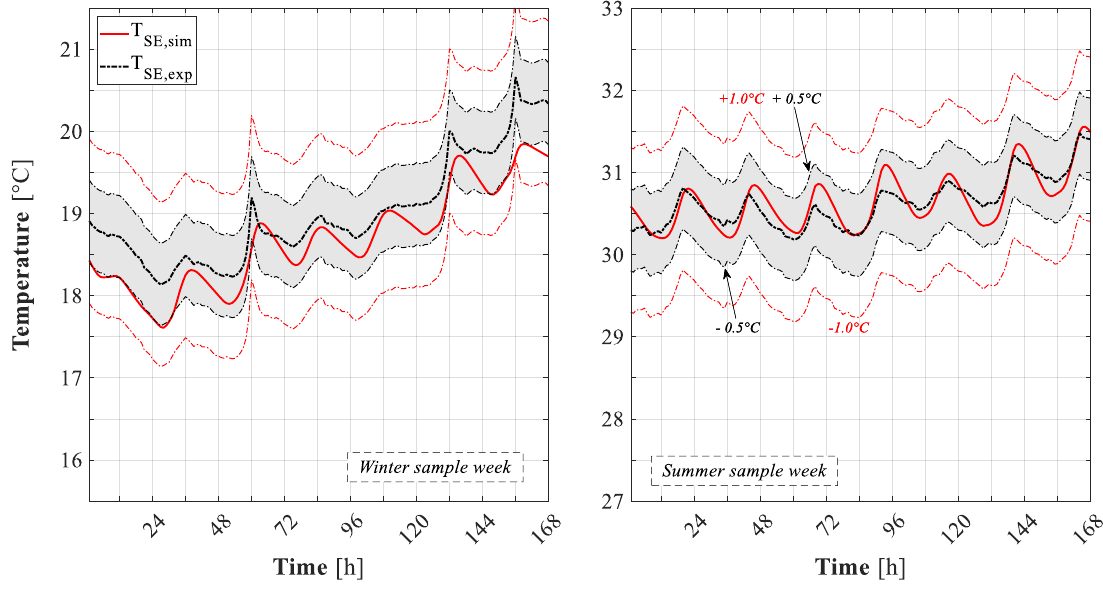
Figure 16. South-East wall temperature: simulated vs. experimental results (two sample weeks).